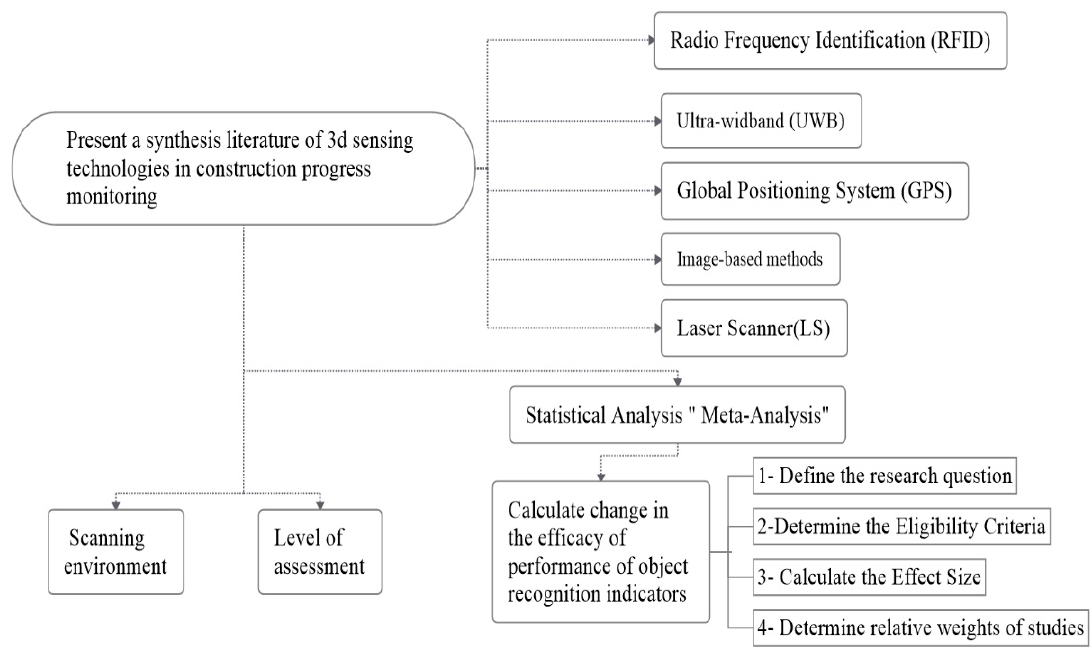
Figure 1. Number of articles per year regarding 3D sensing technologies integrated with BIM in CPM.